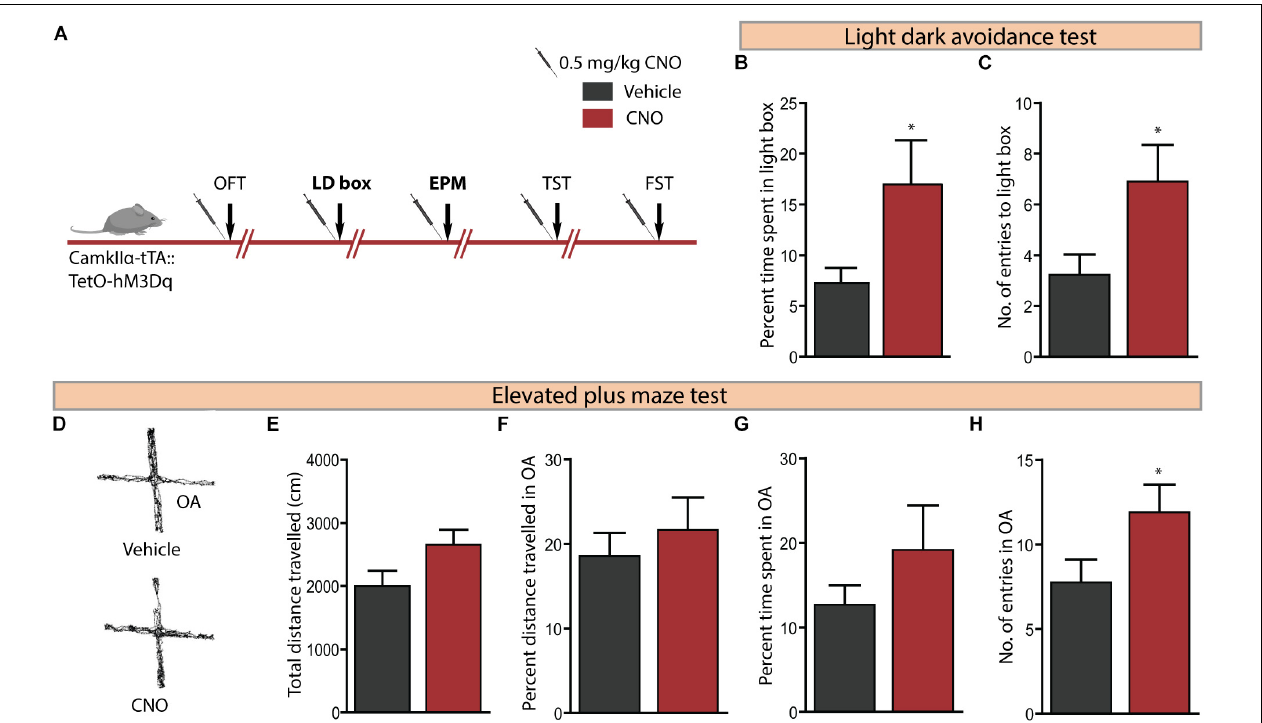
FIGURE 3 | Acute CNO-mediated DREADD activation of CamKII α -positive forebrain excitatory neurons reduces anxiety-like behaviour on the light dark avoidance and EPM test. (A) Shown is a schematic of the experimental paradigm used to determine the influence of acute CNO (0.5 mg/kg)-mediated hM3Dq activation of CamKII α -positive forebrain excitatory neurons in adult male bigenic CamKII α -tTA:TetO-hM3Dq mice on anxiety and despair-like behaviour. Treatment groups were subjected to a battery of anxiety and despair-like behavioural tasks, with an interim washout period of 7–10 days ( n = 9–10/group). Shown in this figure is the anxiety-like behaviour on the light–dark avoidance test (LD) (B,C) and EPM test (D–H) following acute hM3Dq DREADD activation of forebrain excitatory neurons, commencing 30 min following CNO administration. CNO-mediated hM3Dq DREADD activation of CamKII α -positive forebrain excitatory neurons resulted in a decline in anxiety-like behaviour on the LD avoidance test as revealed by significant increases in percent time spent in the light chamber (B) and number of entries made to the light chamber (C) of the LD avoidance test arena. (D) Shown are representative tracks from a vehicle and CNO treated CamKII α -tTA:TetO-hM3Dq mouse in the EPM test. CNO-mediated hM3Dq DREADD activation of CamKII α -positive forebrain excitatory neurons resulted in no change in the total distance travelled (E) , percent distance travelled in the open arms (OA) (F) , and percent time spent in the open arms (G) of the EPM compared to the vehicle-treated group. A significant increase in the number of entries to the open arms of the EPM arena (H) was noted following hM3Dq DREADD activation of forebrain excitatory neurons. Results are expressed as the mean ± SEM ( n = 9–10/group), ∗ p < 0.05, as compared to vehicle-treated CamKII α -tTA:TetO-hM3Dq mice, two-tailed, unpaired Student’s t -test. OFT, open field test; TST, tail suspension test; FST, forced swim test.